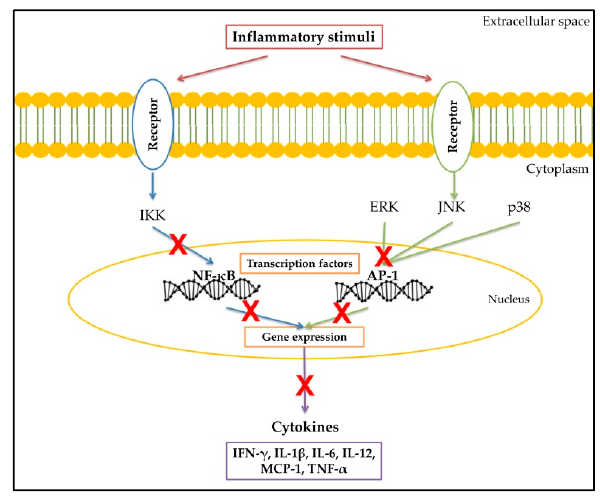
Figure 3. Mechanisms involved in the anti-cytokine effect of flavonoids. The red “X” indicates negative regulation of cytokine synthesis by flavonoids.